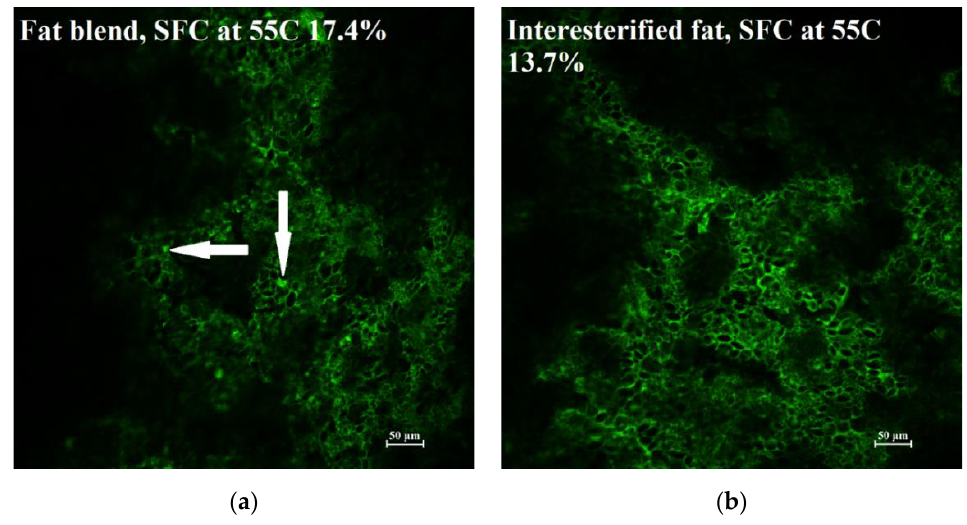
Figure 5. Confocal images of crackers made with either ( a ) a fully hydrogenated soybean fat (17.2%) and soybean oil (82.8%) blend or an ( b ) interesterified soybean oil.